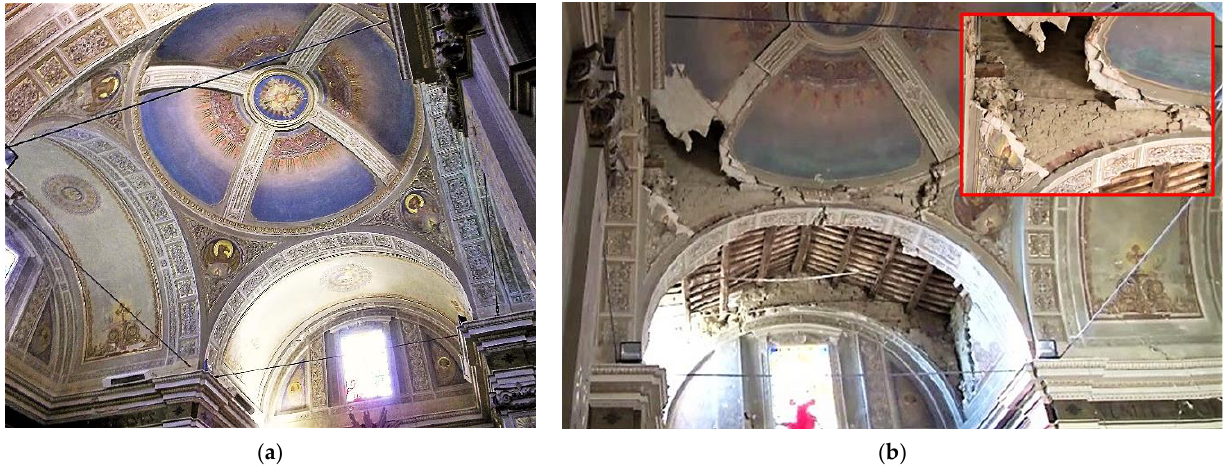
Figure 16. The dome in St. Savino church in Gualdo, before ( a ) and after ( b ) the earthquake occurred on 30 October 2016.